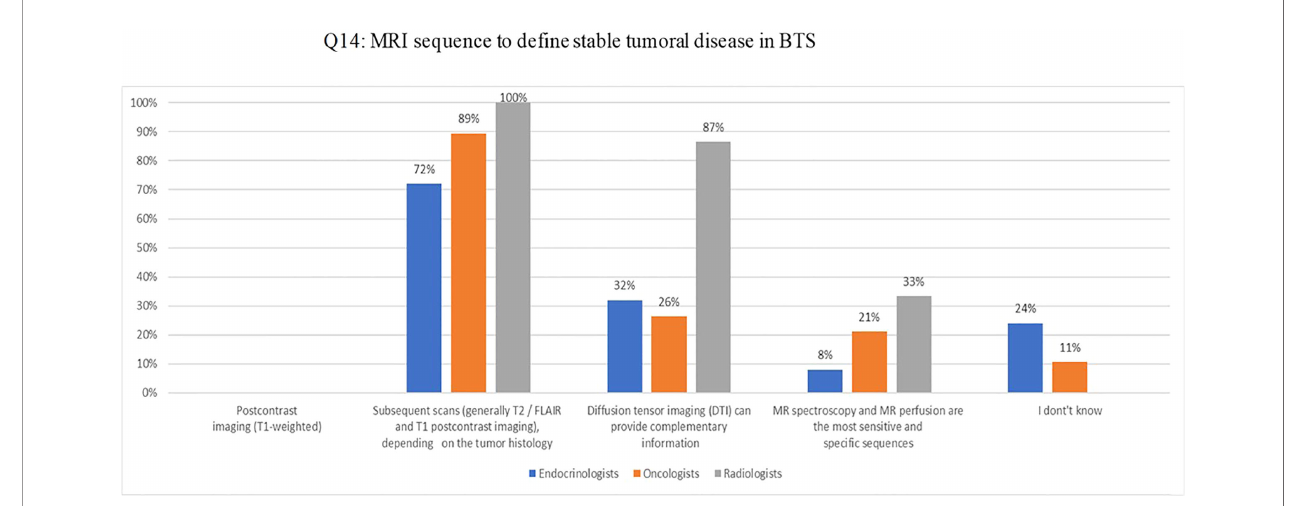
FIGURE 4 | Q14: MRI sequence to de fi ne stable tumoral disease in